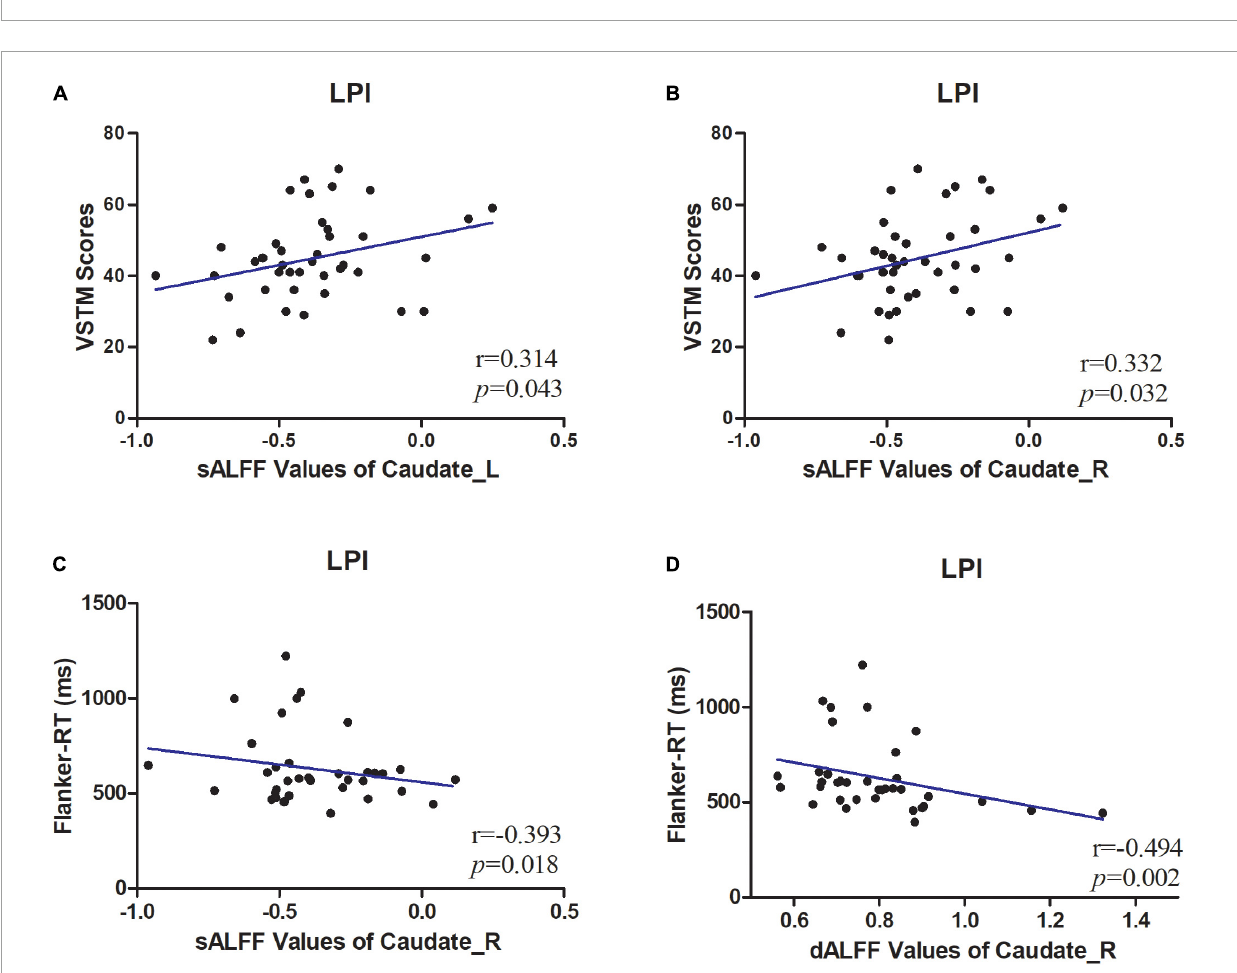
FIGURE4 Correlations between sALFF/dALFF values and behavioral scores. (A) The patients in LPI group shown a significantly positive correlation between sALFF values of CN_L and verbal short-term memory (VSTM) scores. (B) The patients in LPI group shown a significantly positive correlation between sALFF values of CN_R values and VSTM scores. (C) The patients in LPI group shown a significantly negative correlation between sALFF values of CN_R and Flanker-RT scores. (D) The patients in LPI group shown a significantly negative correlation between dALFF values of CN_R and Flanker-RT scores. dALFF, dynamic amplitude of low-frequency fluctuations; LPI, left pontine infarction; RPI, right pontine infarction; sALFF, dynamic amplitude of low-frequency